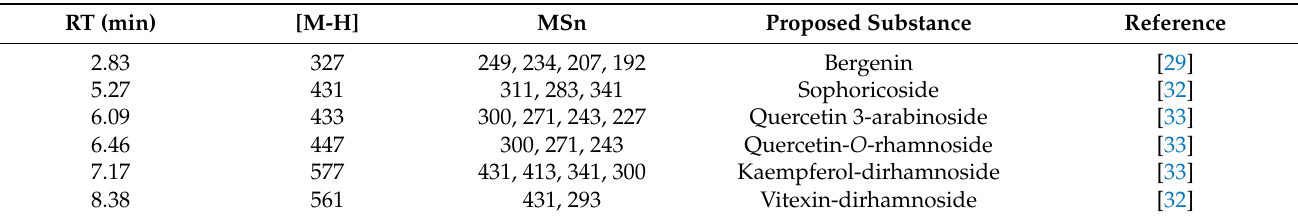
Table 4. Identification of the substances present in the Humiria balsamifera (Aubl) ethyl acetate leaf